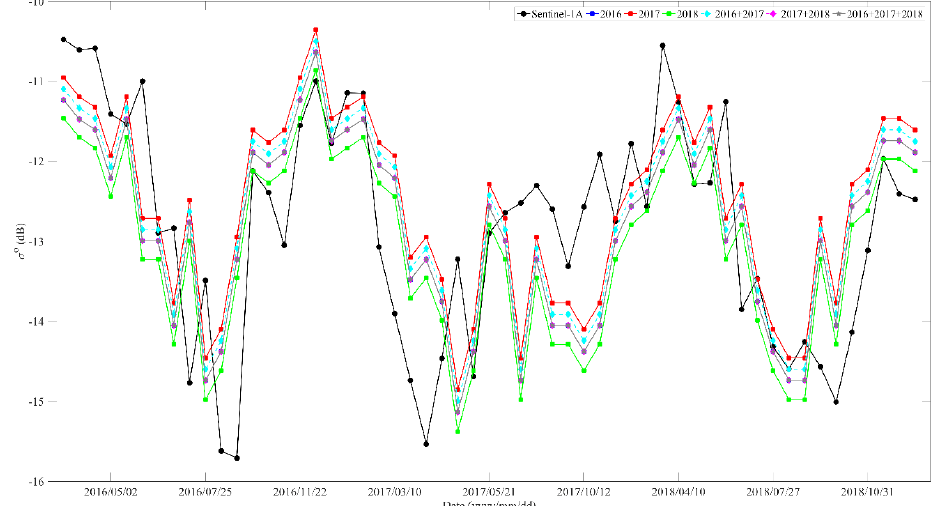
Figure 5. Time series of Sentinel-1A backscatter and simulated backscatter from AIEM with different effective roughness parameters computed from ( a ) 2016, ( b ) 2017, ( c ) 2018, ( d ) 2016+2017, ( e ) 2017+2018, and ( f ) 2016+2017+2018.